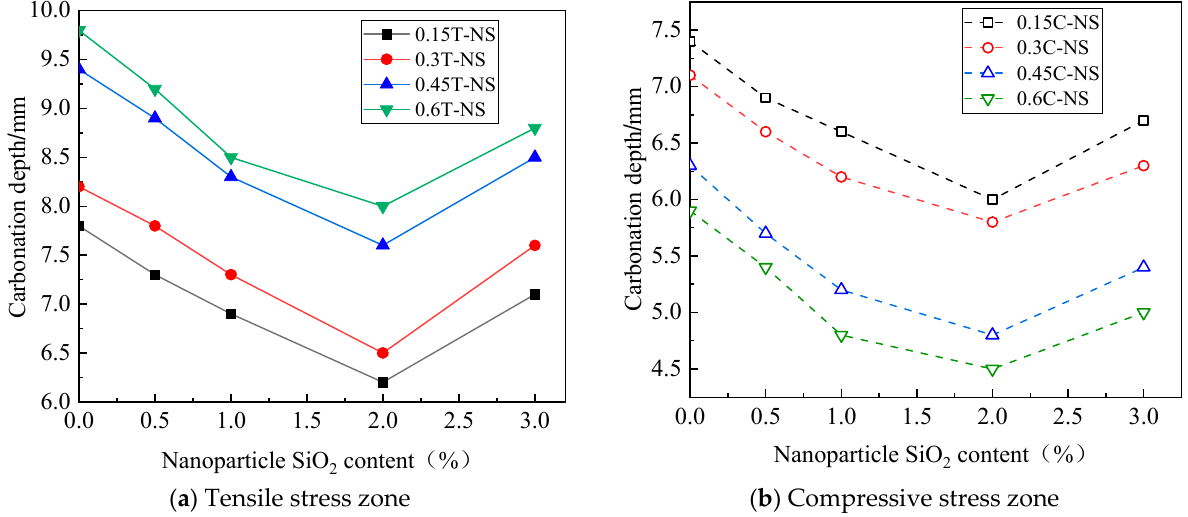
Figure 4. Relationship between carbonation depth of concrete with nano-SiO 2 and nano-SiO 2 content (age: 28 days).